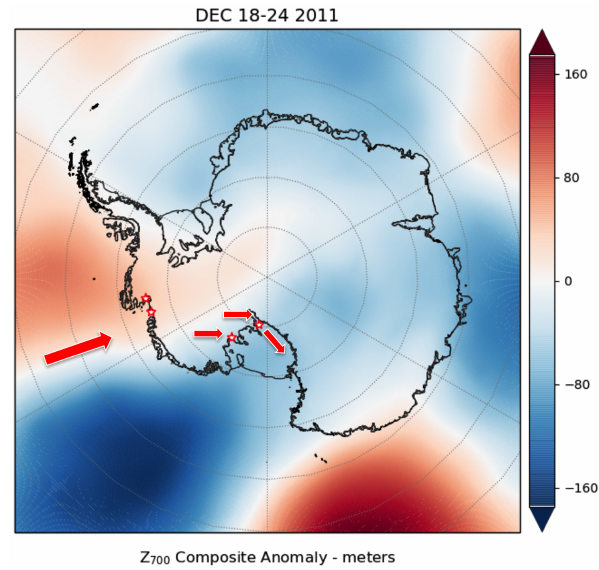
Figure 14. Composite anomaly of ERA 700hPa geopotential height for 18–24 December 2011. The red stars depict the locations of all three case study locations. The red arrows depict the direction of 700hPa winds relevant to the case